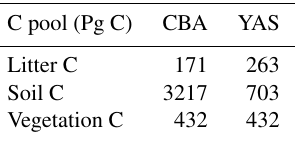
Table 1. Global C storage in the two different model formulations averaged over 2000–2014. For the YAS model, the eight above- ground pools are summed to obtain the litter pool, while the remain- ing 10 pools (below ground and humus) represent the soil pool.